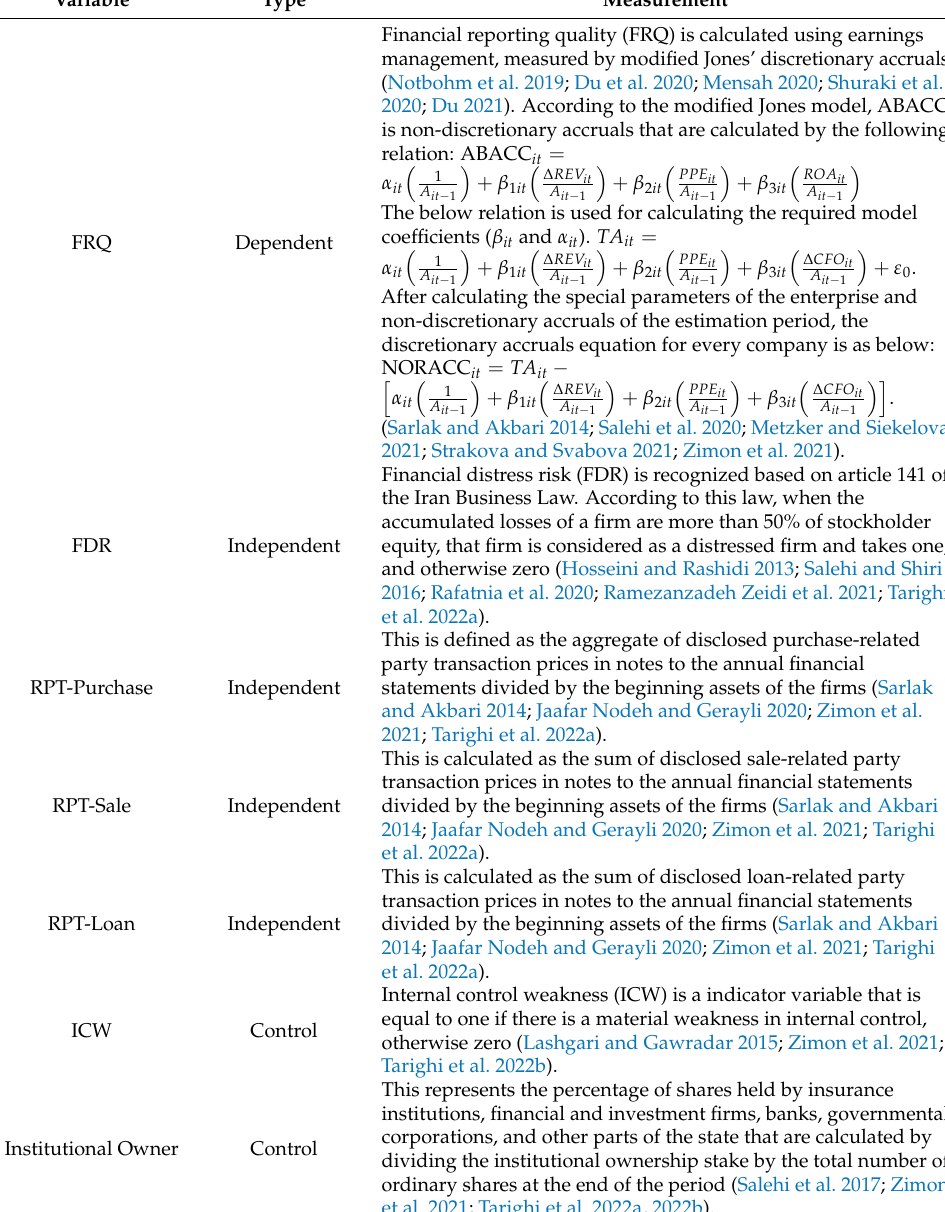
Table 2. Definition of the